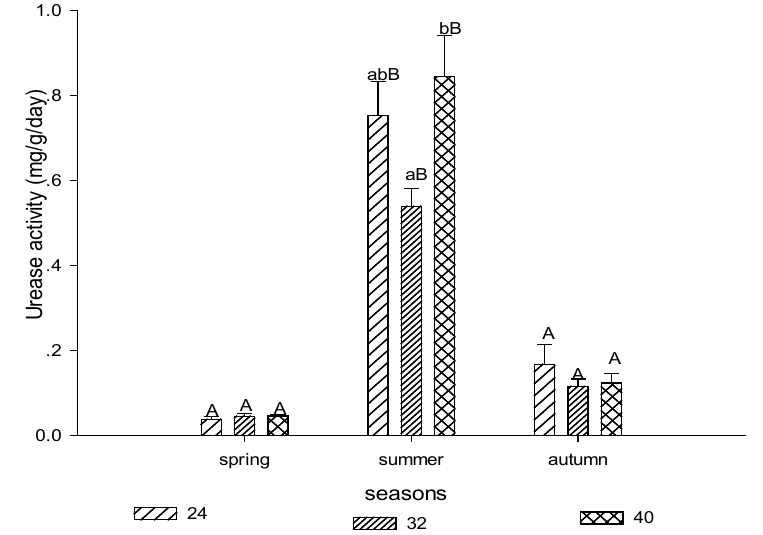
Figure 2. Change in urease activity during the growing season in stands with different times since thinning (24, 32 and 40 years). Within a time since thinning, capital letters indicate statistically significant differences among different seasons; lowercase letters indicate statistically significant differences among different times since thinning within the same season. Bars indicate the standard error of the mean.